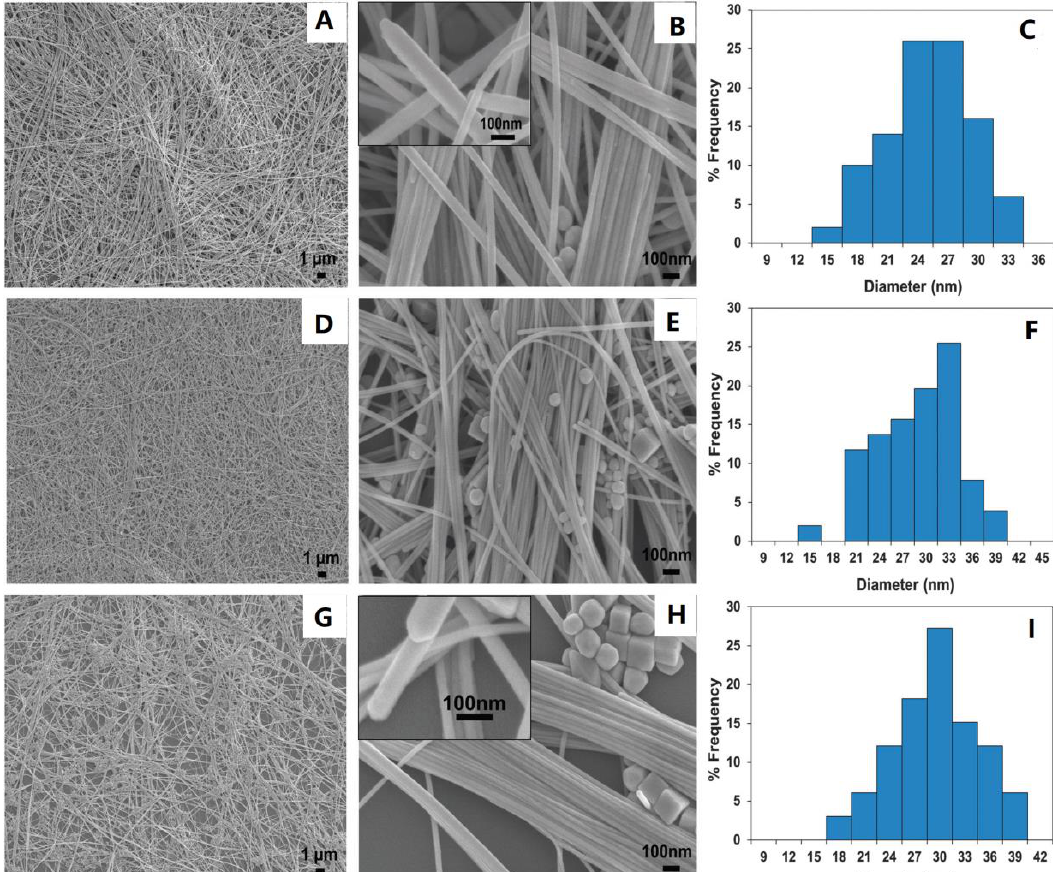
Figure 4. Field-emission scanning electron microscope (FESEM) images of copper nanowires